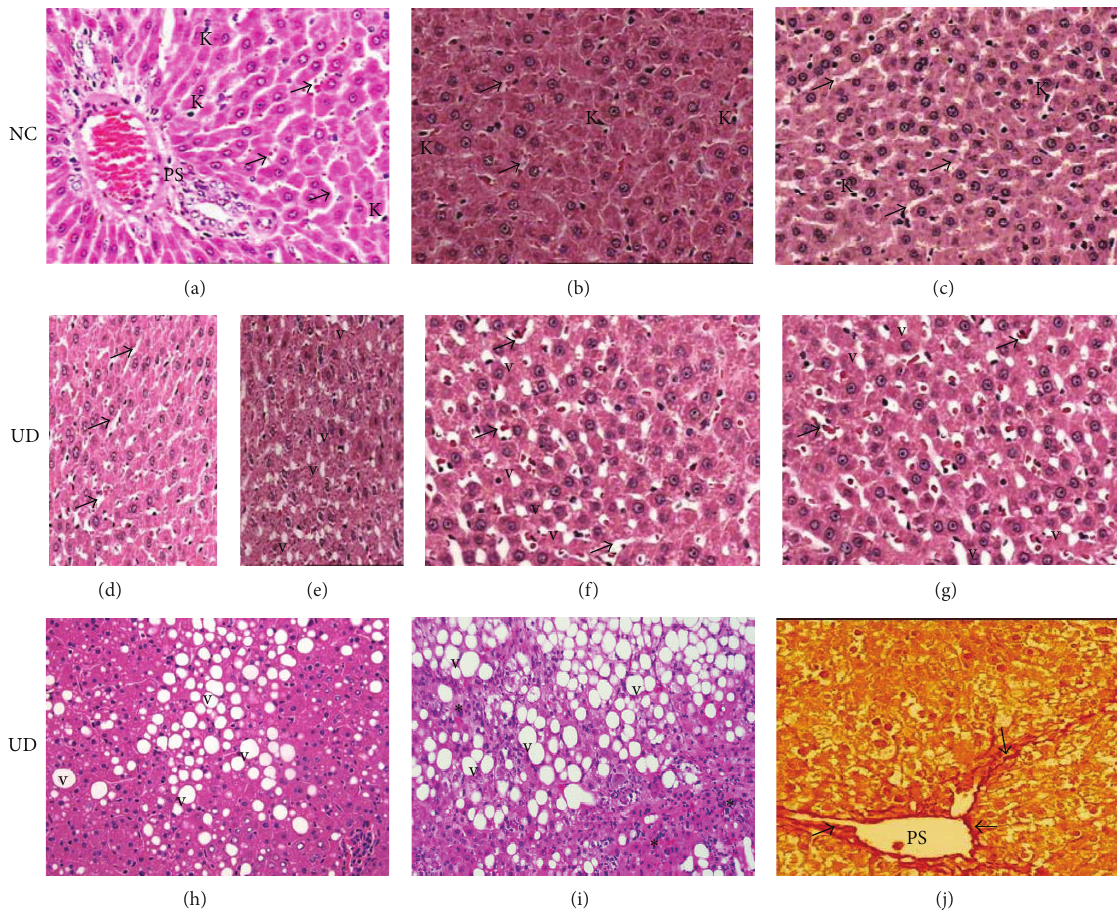
Figure 2: (a), (b), and (c): histological pattern of liver from nondiabetic control rats (NC) showing normal-appearing of hepatocytes, portal space (PS), sinusoids (arrows), and Kuppfer cells (K) at 6, 14, and 26 weeks of follow-up, respectively. Focal area of mild steatosis ( ∗ ) is observed in NC rats sacrificed at 26 weeks. (d) and (e): liver from untreated diabetic rats (UD) sacrificed at 6 weeks showing the onset of sinusoidal enlargement (arrows) and small amount of fatty vacuoles (v), respectively. (f) and (g): liver from UD rats sacrificed at 14 and 26 weeks showing progressive worsening of sinusoidal enlargement (arrows) and liver fatty degeneration (v), respectively. Liver from UD rats at 26 weeks showing in (h) macrovesicular fatty degeneration (v); (i) interlobular mononuclear inflammatory infiltrate consistent with steatohepatitis ( ∗ ); (j) periportal (PS) fibrosis (arrows). H&E and red picrosirius